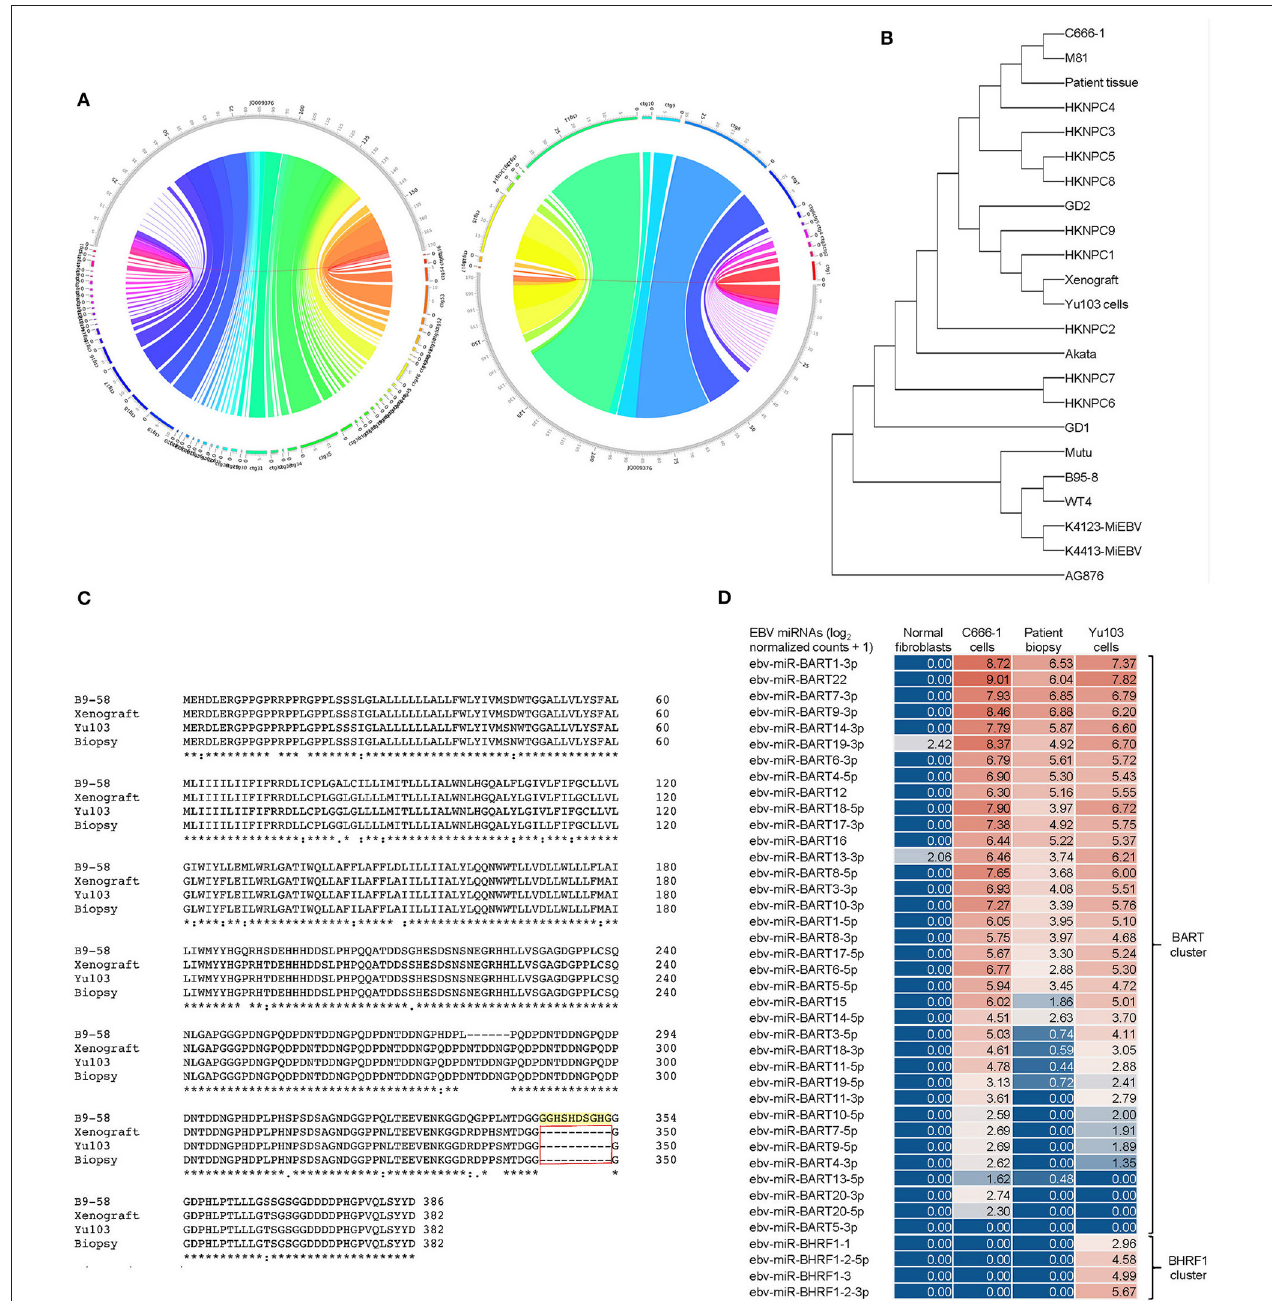
FIGURE 5 | Molecular characterization and phylogenetic analysis of Yu103 EBV. (A,B) Neighbor-joining phylogenetic tree depicting the genomic relatedness of EBV strains based on whole-genome sequencing with maximum composite likelihood. We compared n = 23 EBV isolates including Yu103 cells (original patient tissue, xenograft, and purified cell line), NPC strains (M81, C666, HKNPC, GD1, GD2), gastric cancer strains and lymphoma strains (Raji, AG876 and Akata) All positions containing gaps and missing data were eliminated, with a total of 123,852 positions in the final dataset. (C) Amino acid sequence variation between the variant LMP1 genes derived from B95-8, Yu103 cell, xenograft and original NPC biopsy. Asterisks (*) indicate positions with a single, fully conserved residue; colons (:) indicate strong conservation with scores of > 0.5 in the Gonnet PAM 250 matrix; periods (.) indicate weak conservation with scores of ≤ 0.5 in the Gonnet PAM 250 matrix; and dashes (-) represent deleted amino acids. Yu103 EBV from the Singapore Chinese male in this study was found to harbor a 30-base pair deletion in LMP1 (observed in the original patient biopsy, xenograft, as well as isolated Yu103 cells) which is known to occur at a high prevalence among EBV strains isolated from Hong Kong Chinese patients with undifferentiated nasopharyngeal carcinoma. (D) Microarray-based miRNA scrutiny demonstrated that Yu103 EBV shared a similar BamHI A Rightward Transcripts (BARTs) miRNA expression profile as that of the prototypical EBV-positive NPC cell line, C666-1. However, a major distinction was that a cluster of miRNAs which regulate BHRF1 , the viral homolog of the Bcl-2 proto-oncogene, was exclusively expressed by Yu103 but not C666-1 EBV, which may account for Yu103’s peculiar ability to efficiently infect and subsequently induce lymphomagenesis in B cells. miRNA expression was analyzed on a log 2 [normalized counts + 1]